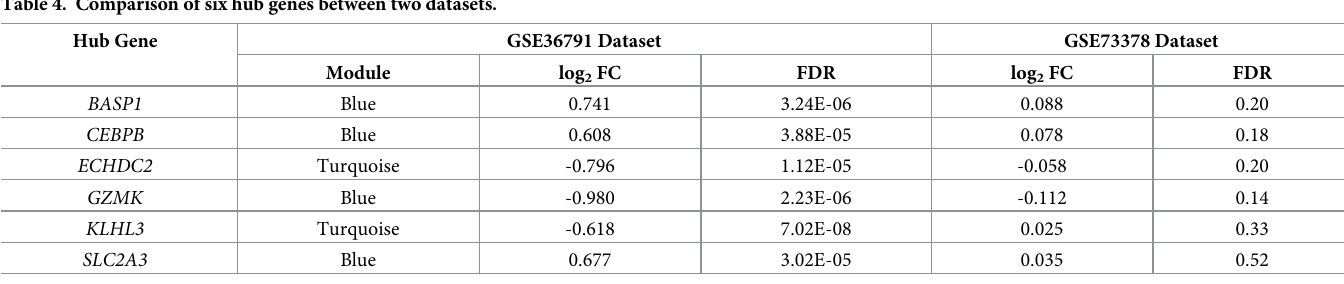
Table 4. Comparison of six hub genes between two